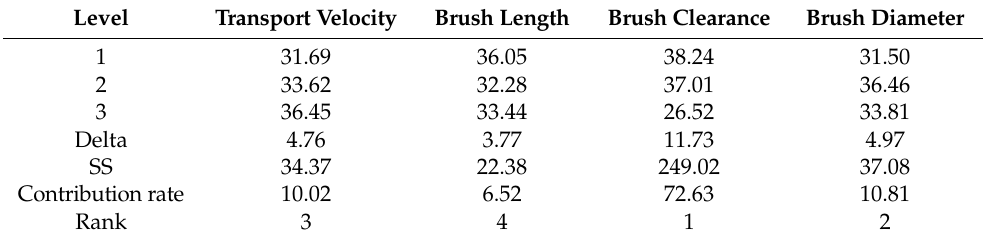
Table 7. Response table for eliminate S/N ratios of jujube-shaped cherry tomato.